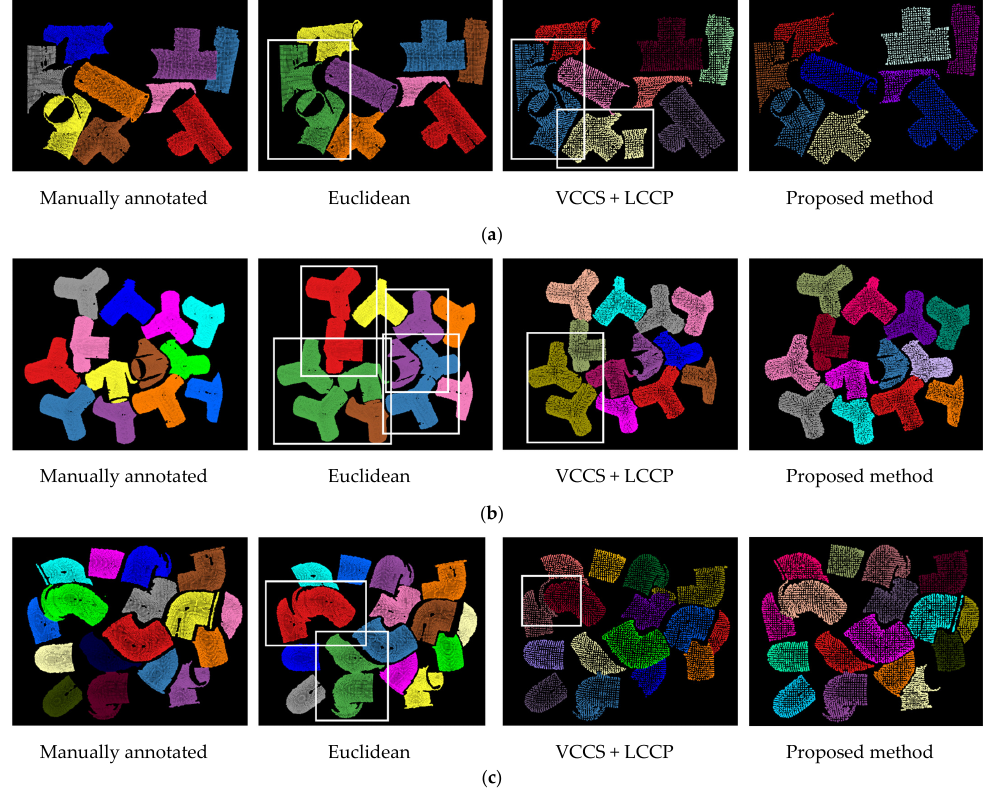
Figure 12. Results of the comparison of different workpieces. ( a ) Tee pipe 1. ( b ) Tee pipe 2. ( c ) Two-way elbow. Mis-segmentations are demonstrated by white boxes. (Points were enlarged for visual- ization). Table 3. The comparison of performance.